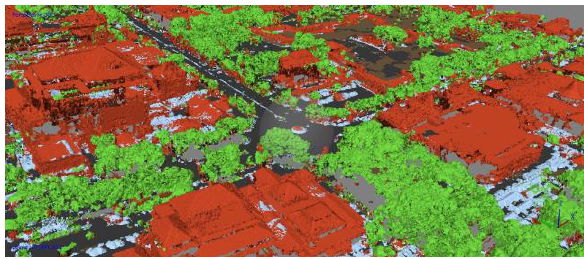
Figure 3. Classified point cloud obtained from Agisoft